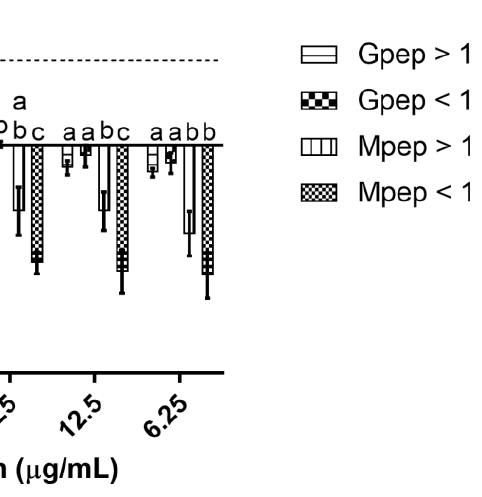
Figure 2. Peptide fractions impact upon HaCat cells metabolic activity. Different letters represent the statistically significant ( p < 0.05) differences found between the four samples tested at each con- centration assayed. The dotted line represents the 30% cytotoxicity limit as defined by the ISO 10993- 5:2. When considering the impact upon human fibroblasts (Figure 3), the impact pre- sented is quite different. The first major takeaway is that contrary to what was observed for HaCat, the fractions assayed clearly impacted HDFa metabolism with the highest